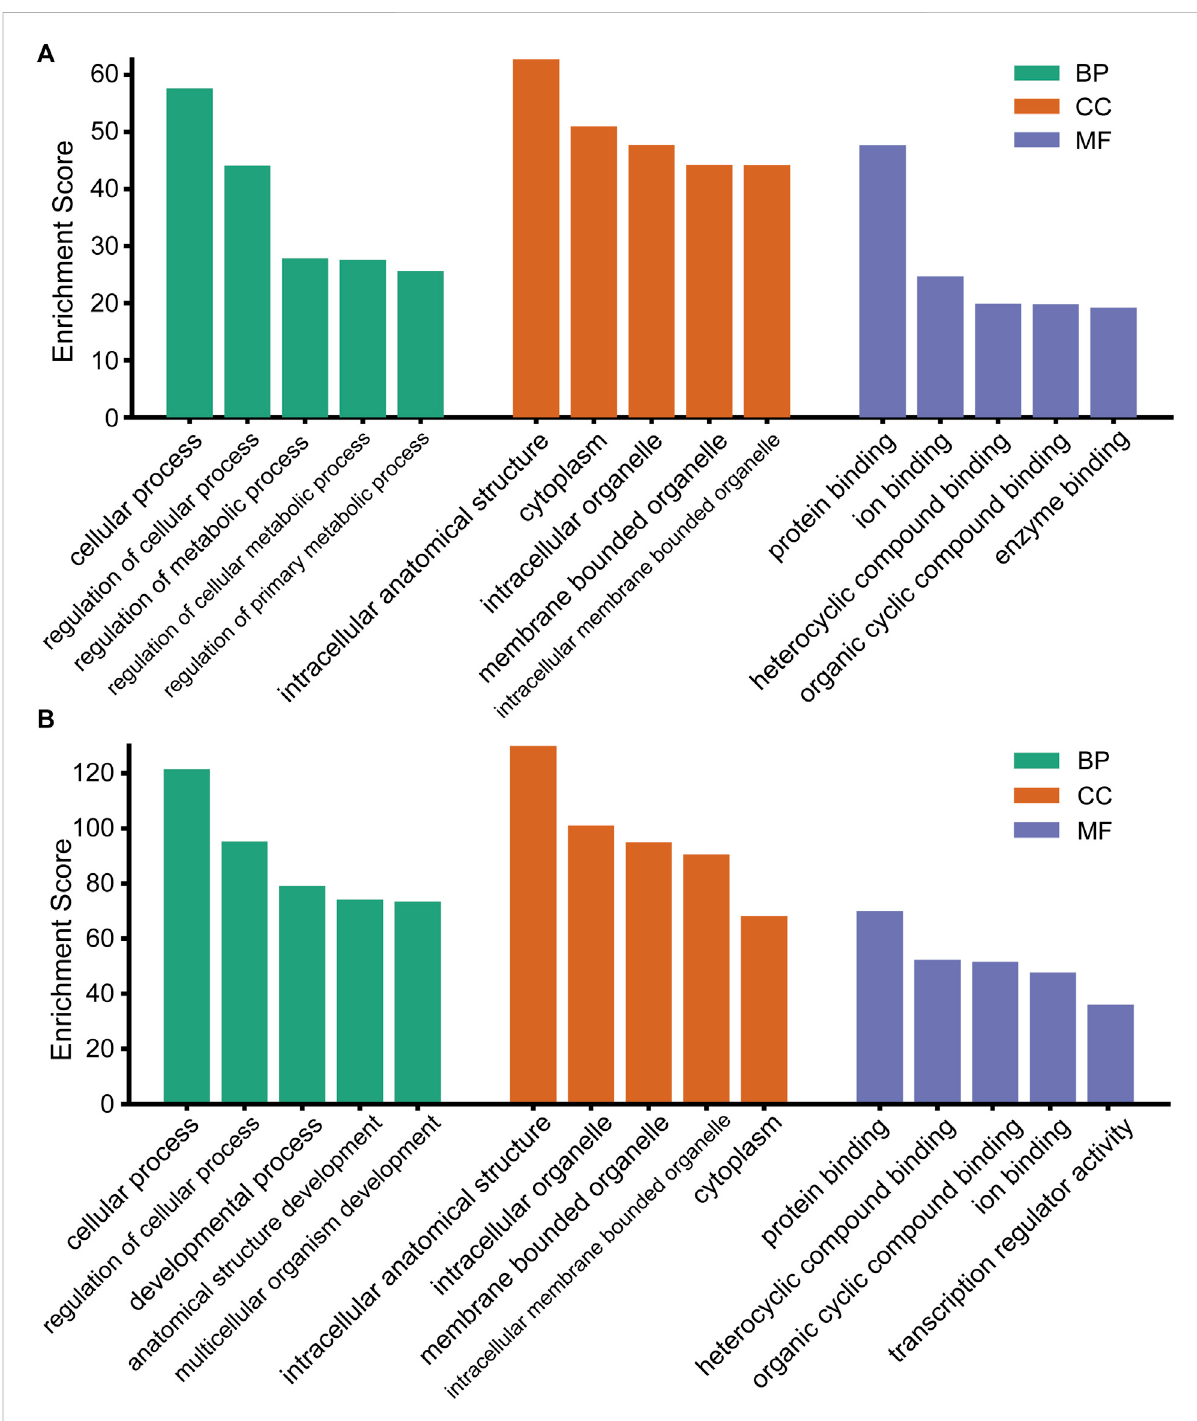
FIGURE 3 GO analysis of the target genes of DEmiRs. (A) GO terms for the upregulated DEmiRs. (B) GO terms for the downregulated DEmiRs.